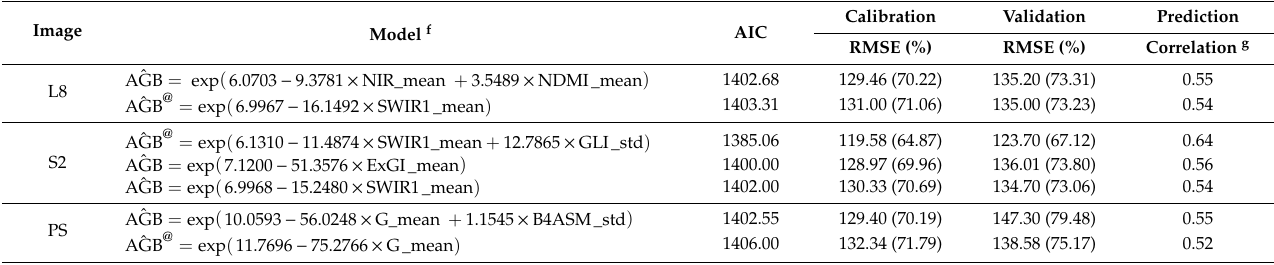
f Mean and std refer to the area-weighted mean and standard deviation of the image-derived variables within the grid cells. @ Selected model for AGB prediction (from each image type). g Pearson correlation coe ffi cient between ground reference and model-predicted values of AGB for the models in each image type. The square of these coe ffi cients is the same as the R 2 of the models, which was determined using Equation (3).